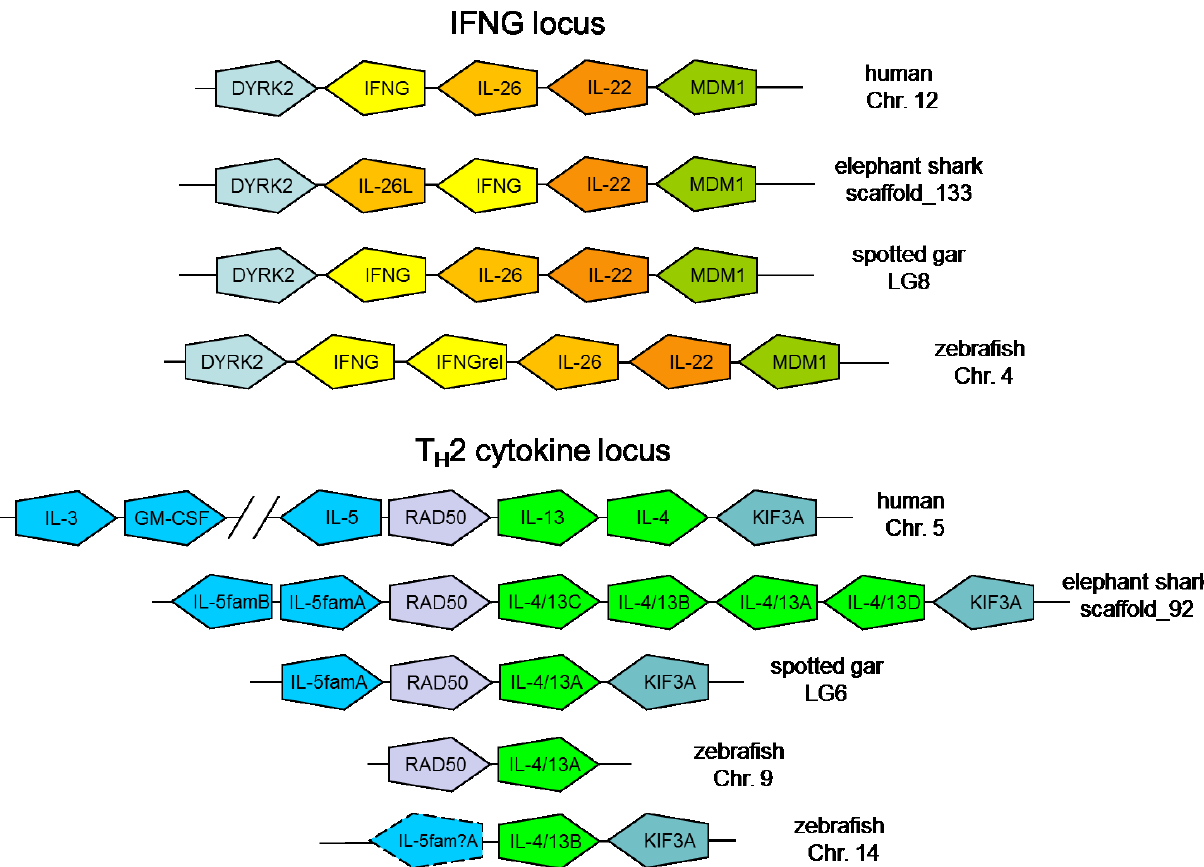
Figure 2. Schematic depiction of the conservation of the IFNG and T H 2 cytokine loci in fish and mammals. The pentagon orientations correspond with gene directions. Depicted gene organizations are based on analysis of genomic sequence information available for elephant shark ( Callorhinchus milii ) provided by the Elephant Shark Genome Project ([118] and GenBank accession number AAVX02000000) and for the other species in the following datasets of the Ensembl database [119]: human ( Homo sapiens ), GRCh38.p2; spotted gar ( Lepisosteus oculatus ), LepOcu1; zebrafish ( Danio rerio ), GRCz10. Between human IL-5 and GM-CSF lays a 465 kb stretch with a number of genes which are not shown in this figure. Most of the depicted gene organizations have been described before [107,120–125]. The deduced elephant shark IL-26L amino acid sequence is MRCAAACLLVSLGVCVVRTSTA TCKPKVSDRLIQDFIRCVGNVMNASQHYWGSSWSDGKGYRFLPKPVKMTKHGKC TVVKKALEFYLIFLKQYRPMPDGFKQDLIKVKHYLEEMYAKTRCDECKSSKDLNAE RAIKRLEKEICKARCSKHTSVTKKSIIFQLYILRNLITNMA. For the deduced encoded elephant shark T H 2 locus cytokine sequences see Table S3 (except for IL-4/13D these are also described in [124]). For the spotted gar IL-4/13A sequence we refer to [125]. The deduced spotted gar IL-5famA sequence is MSMYLVLLILGVHYSGVRTQHYHFISEIISHIENAK QGVVHTILLTPQNVLNANCTASYSKIFLKGIKHLSVHSEHGSQEELKLIIHNMERMD VICPNLKHQVPDCEVQDTSTFQFLRQFTKFLQKIKRSDCFRLRSEYPFSA, which is compared with other sequences in Figure